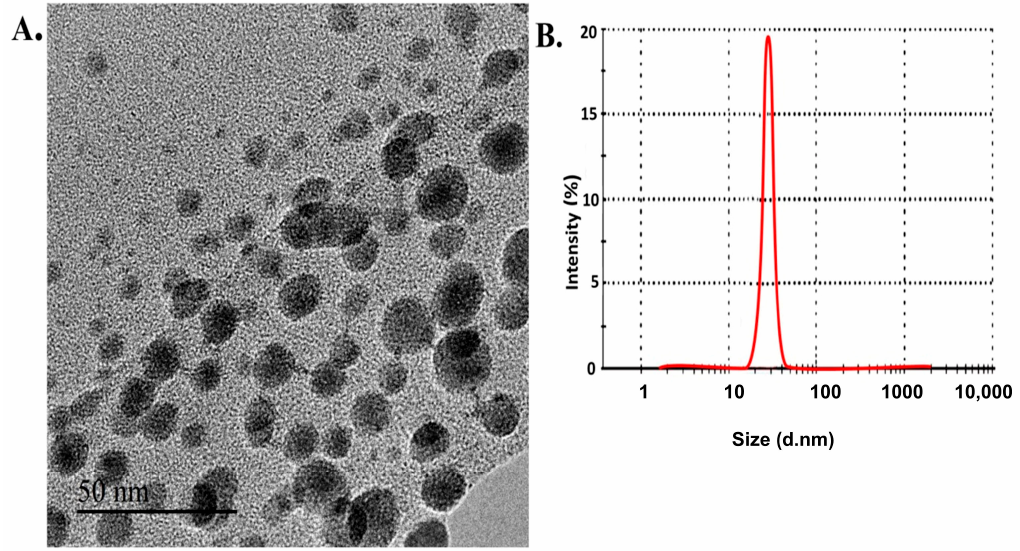
Figure 1. Characterization of lignin-loaded carbon nanoparticles (L-CNPs): ( A ) transmission electron microscope image for lignin nanoparticles (L-NPs) decorated with carbon nanoparticles (C-NPs) producing L-CNPs; ( B ) DLS analysis of L-CNPs.